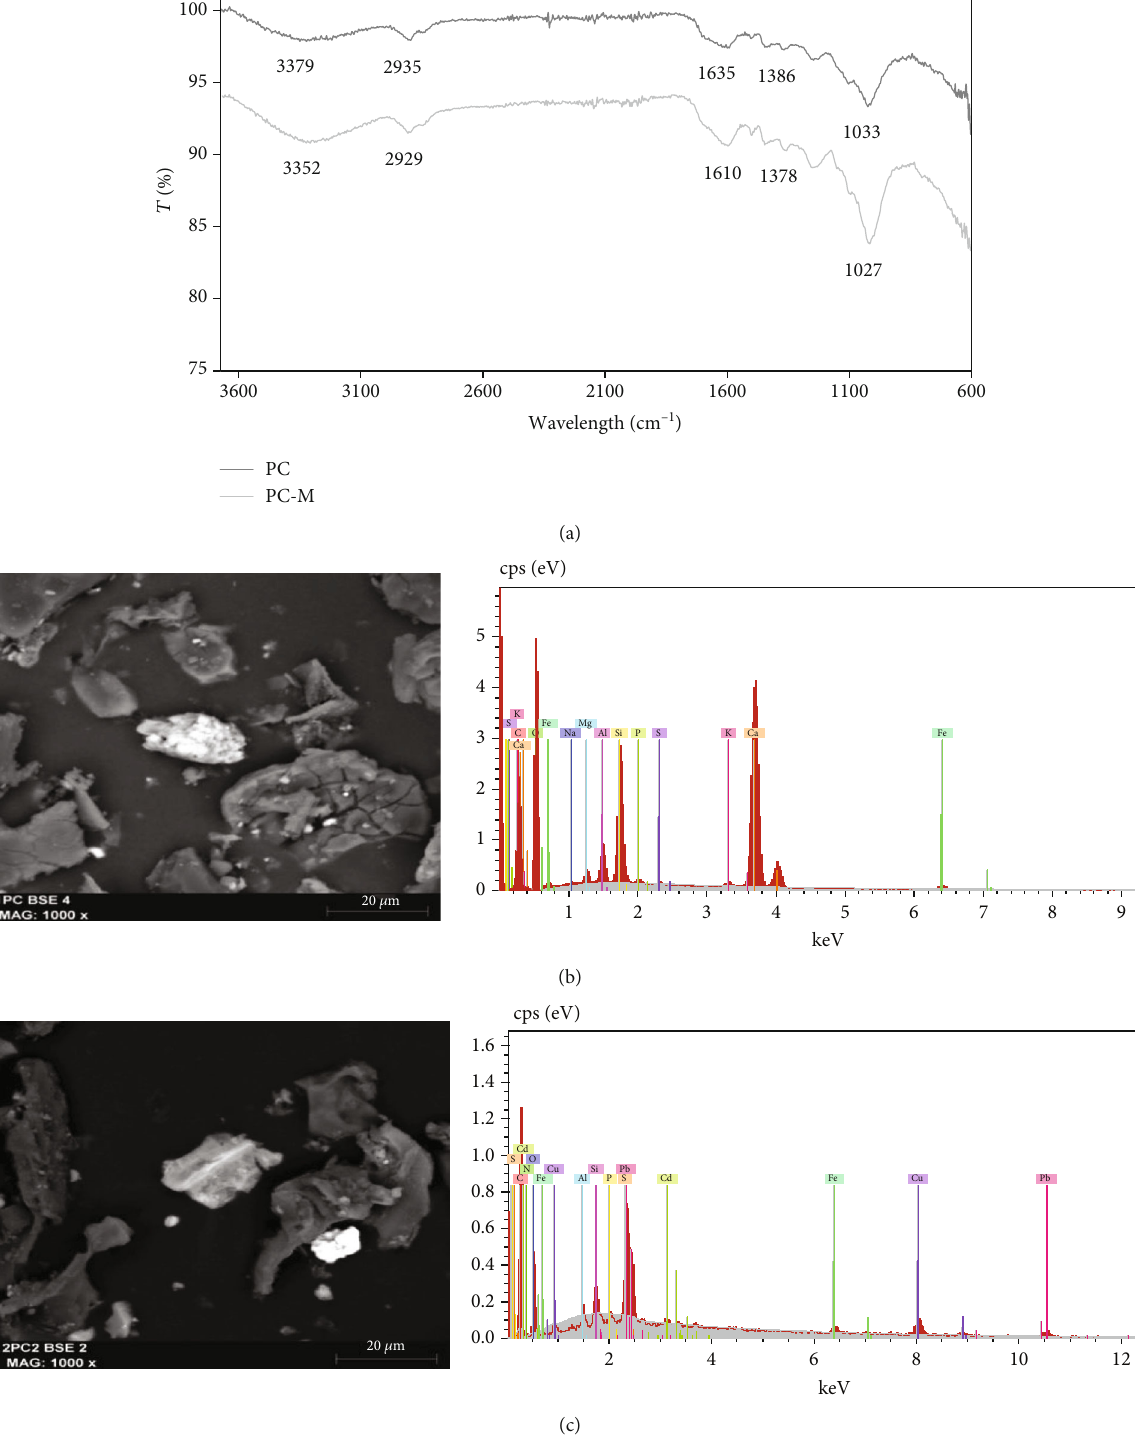
Figure 1: (a) FTIR spectra of pine cone (PC) and pine cone after metal adsorption (PC-M), (b) SEM micrograph and EDX spectra of pine cone, and (c) SEM micrograph and EDX spectra of pine cone after adsorbing Cu(II), Cd(II), and